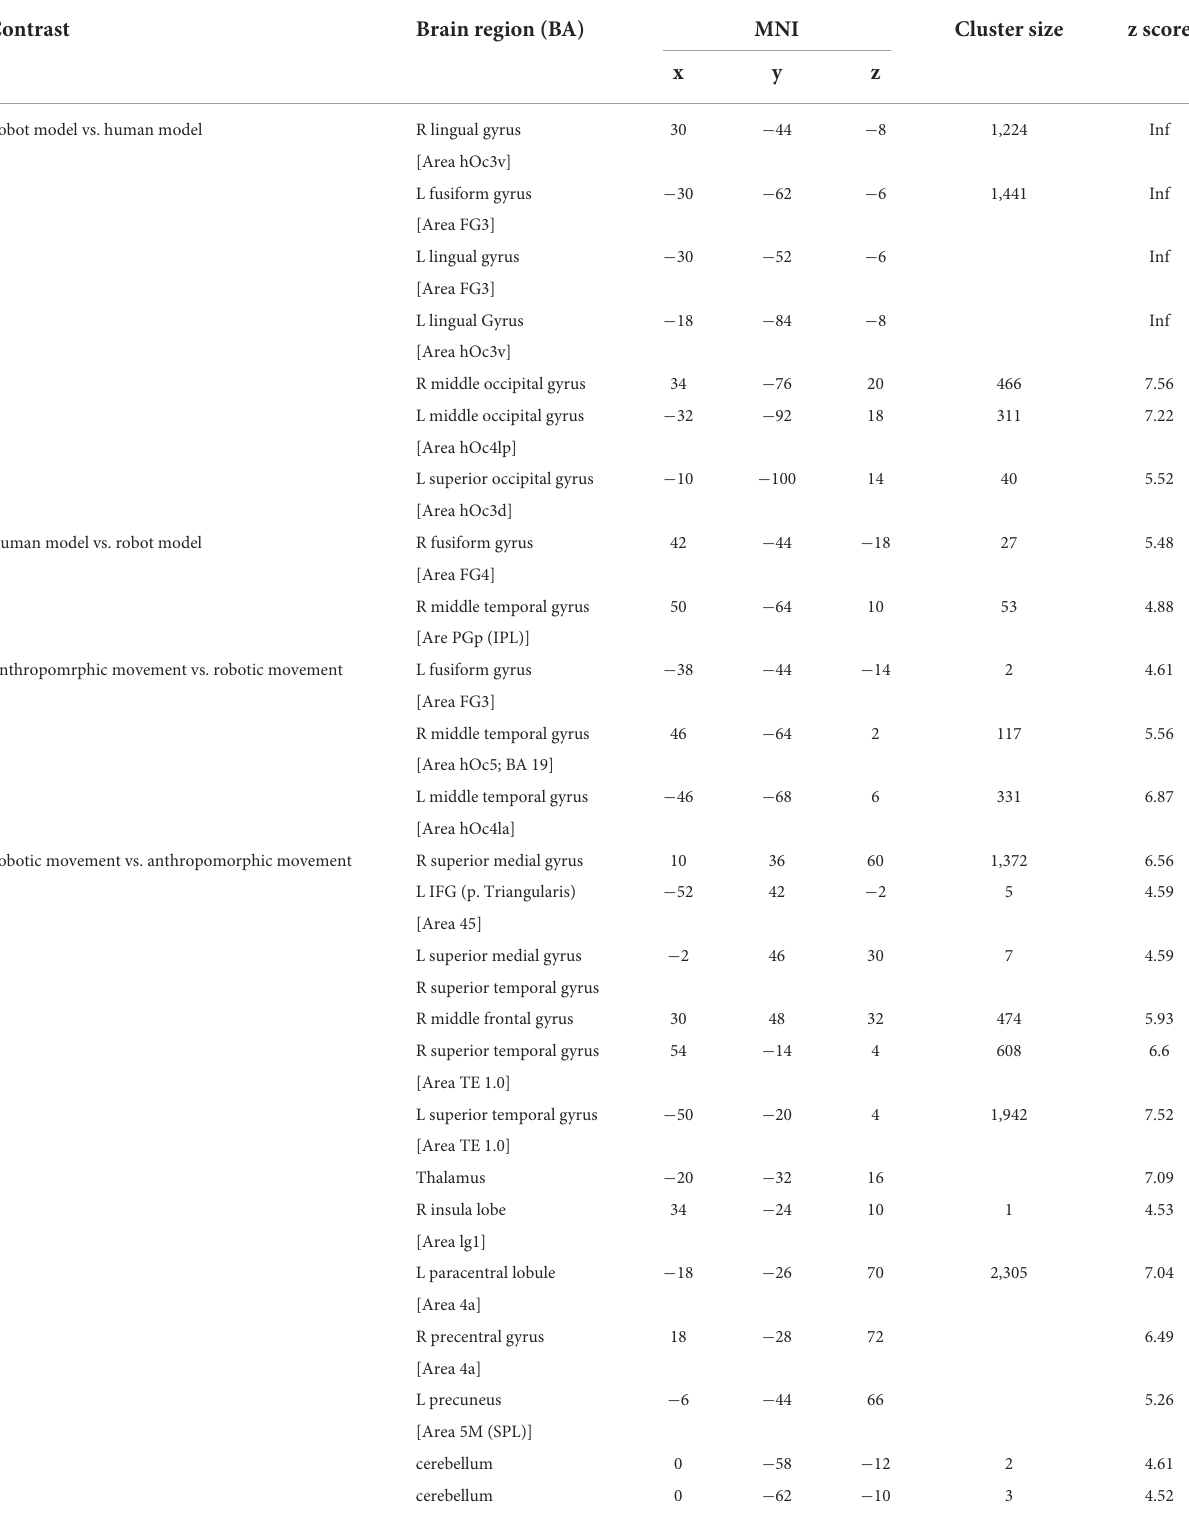
TABLE 2 Significant brain activation differences for main effect. Contrast